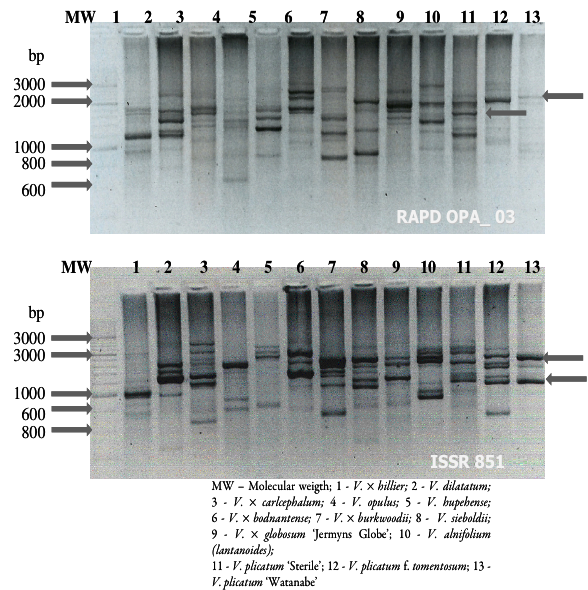
Fig. 1. PCR amplification profiles of 13 Viburnum